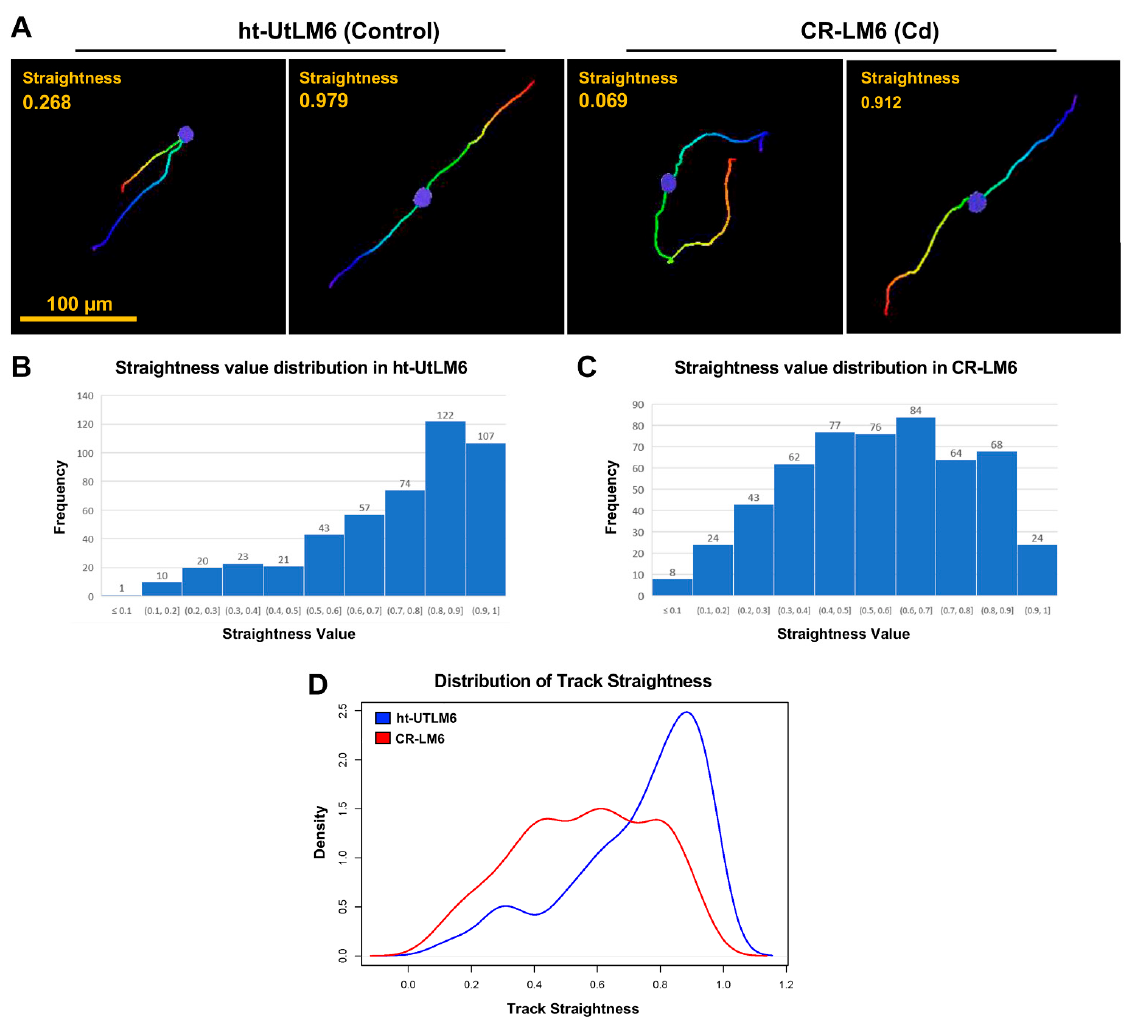
Figure 2. Distribution of Nuclear Track Straightness. ( A ) Tracks with various straightness values. These individual tracks were extracted from the full track displays in Figure 1. The Straightness is defined as the ratio between Track Displacement and Track Length. Scale bar = 100 µm. ( B ) Distribution of Track Straightness in ht-UtLM6. The data labels shown on top of the bars are the absolute counts. The Frequency in Y -axis denotes the number of counts within a specific bin. ( C ) Distribution of Track Straightness in CR-LM6. ( D ) Superimposed probability density function curves of Straightness values for both populations.